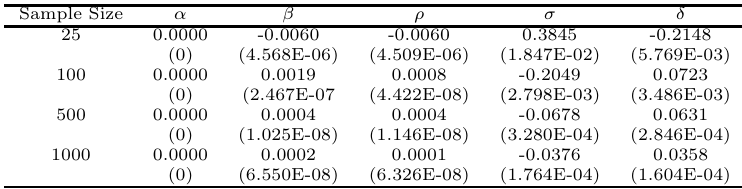
Average bias and mean squared errors(within brackets) of MLEs of the parameters of EKIWD based on simulated data sets corresponding to α = 0 . 1 , β = 0 . 1 , ρ = 0 . 1 , σ = 0 . 1 , δ = 2 .